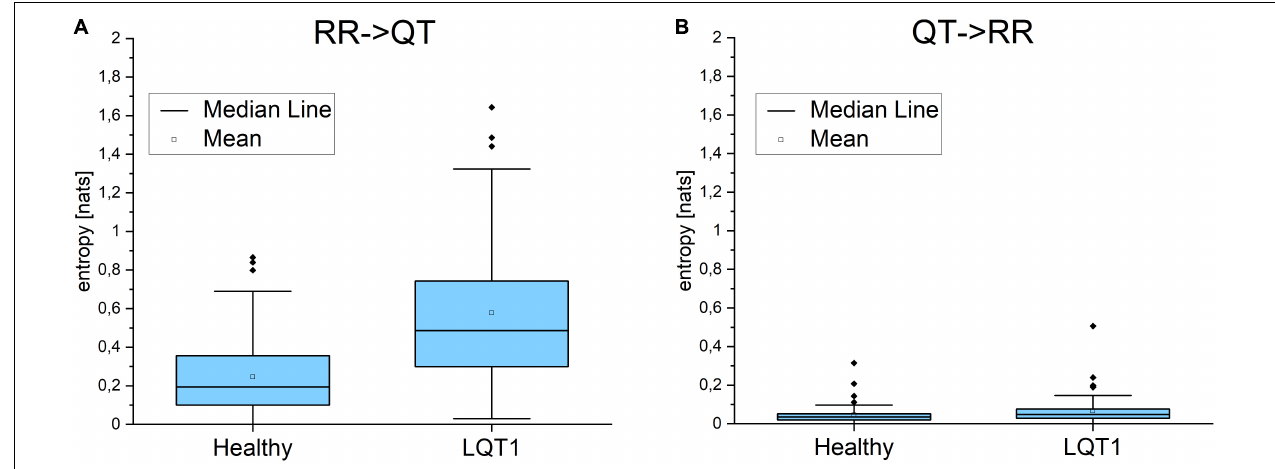
FIGURE 5 | (A) Transfer entropy from the RR intervals to the QT intervals and in the opposite direction (B) for healthy individuals and for LQTS1 patients. p -Values: RR- > QT: 8.46283E-9, QT- > RR: 0.07761.